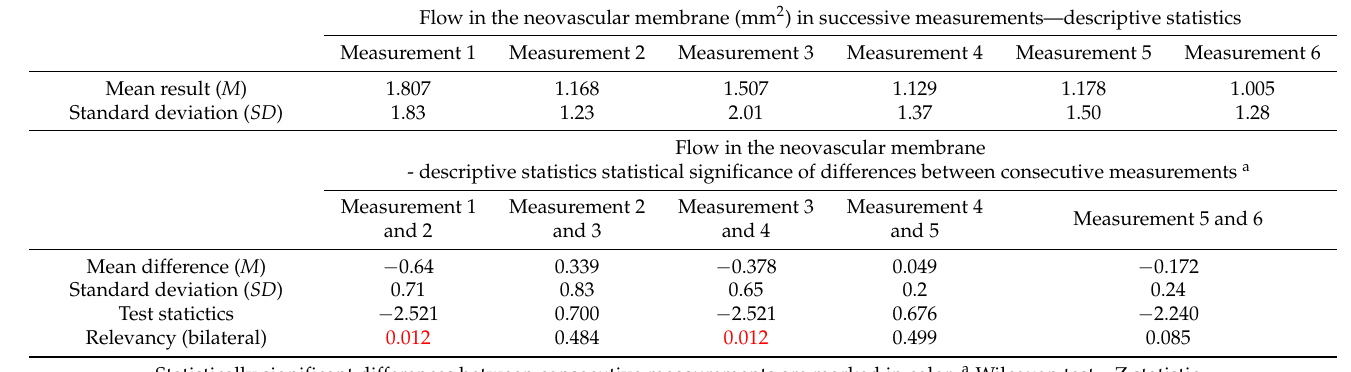
Table 5. Flow in the neovascular membrane-descriptive statistics and statistical significance of